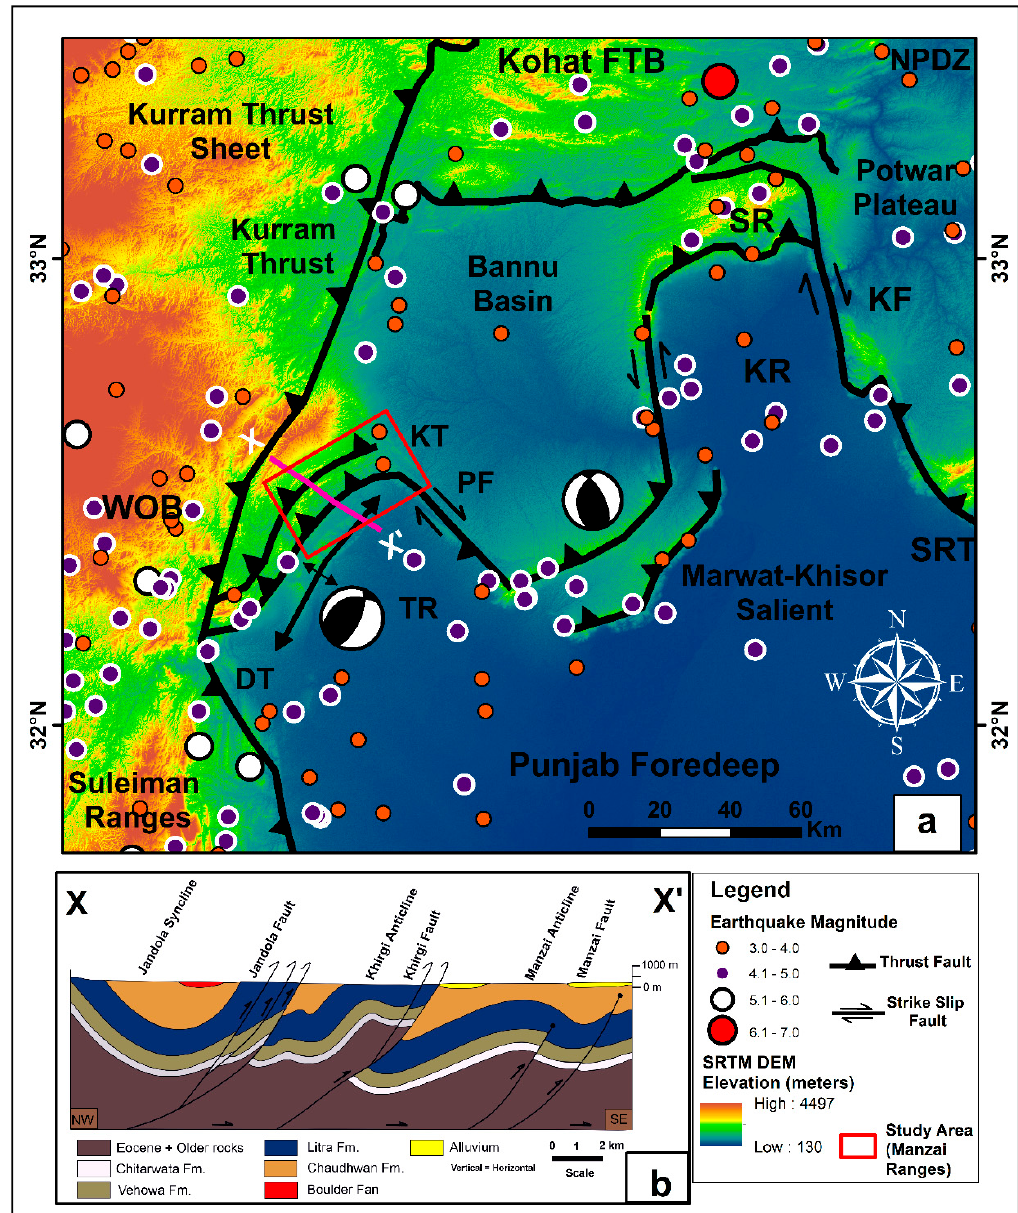
Figure 2. ( a ) Shuttle Radar Topography Mission (SRTM, 30 m) digital elevation model (DEM) showing the geotectonic setting of the western Himalayas Fold–Thrust Belt in the TIR. Earthquake data were acquired from the Pakistan Meteorological Department (PMD) and the United States Geological Services (USGS). Structures are modified after Kazmi and Rana [32]. The focal mechanism solution (FMS) of earthquakes are from Khwaja and Monalisa [33]; ( b ) and 2D seismic interpretation of profile XX’ modified after Ali [28]. The northwest–southeast oriented seismic line cuts across almost all the perpendicular to the major structural elements. This shows the cross-sectional geometry of the Jandola syncline, Jandola Fault, Khirgi anticline, Khirgi Thrust, Manzai anticline and Blind Manzai Fault. These structural elements are dipping northwest and show southeast vergence. Stratigraphic units identified on seismic lines are Pleistocene and younger, while Eocene and older age rocks are undifferentiated and are shown as a single unit. NPDZ: Northern Potwar Deformed Zone, SRT: Salt Range Thrust, KF: Kalabagh Fault, KR: Kalabagh Reentrant, SR: Surghar Range, PF: Pezu Fault, KhT: Khirgi Thrust, TR: Tank Reentrant, WOB: Waziristan Ophiolite Belt, DT: Domanda Thrust.